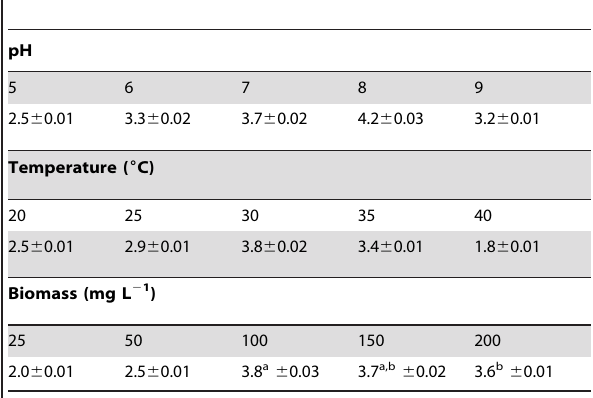
Table 2. Effect of pH, temperature, and biomass on anilofos uptake (mg L 2 1 ) by Synechocystis sp. strain PUPCCC 64.